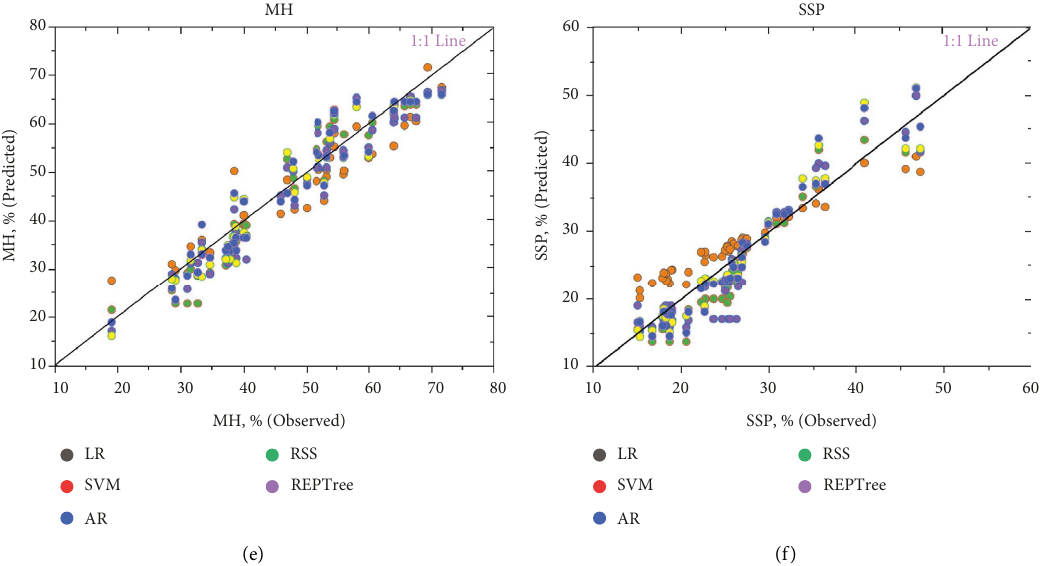
Figure 5: Scatter plots of the predicted and observed values for predicting the LR, SVM, AR, RSS, and REPTree model performance during the testing